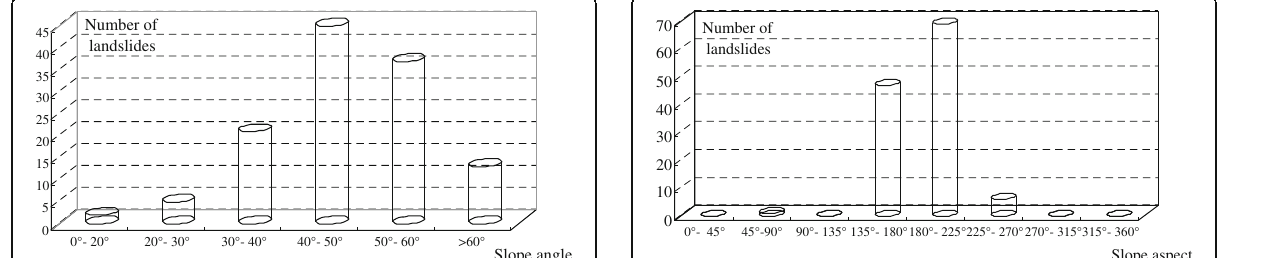
Fig. 15 Relationships between slope angle and landslide occurrence